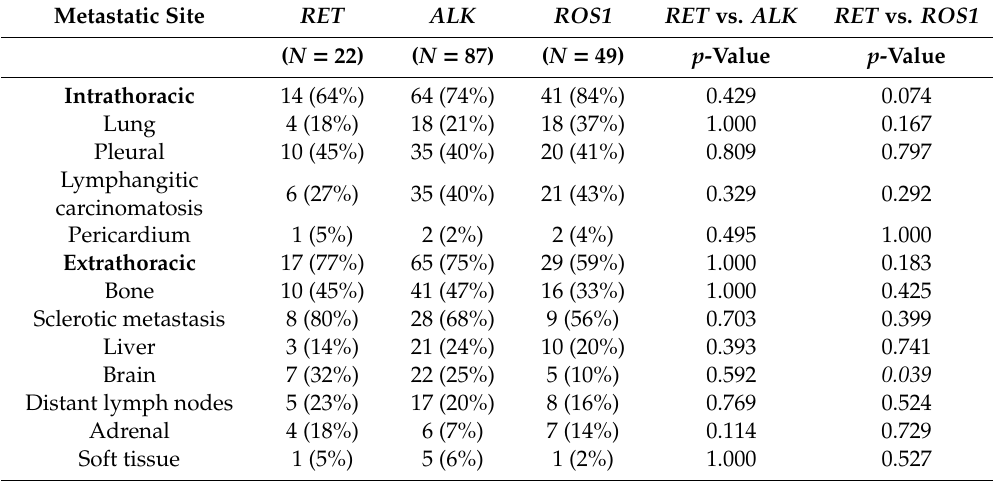
Table 3. Patterns of metastatic sites among patients with advanced RET , ALK , or ROS1 fusion-positive